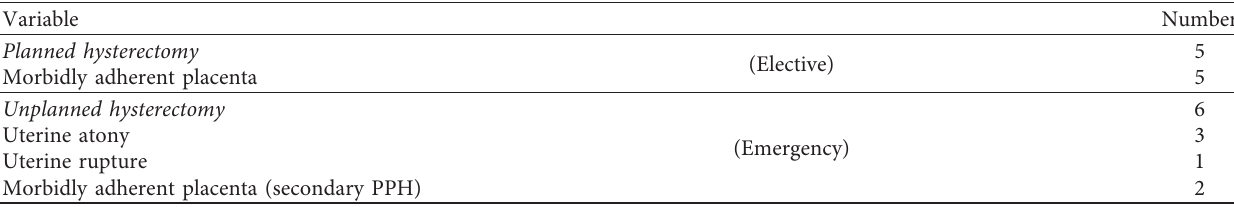
Table 1: Indications for peripartum hysterectomy.